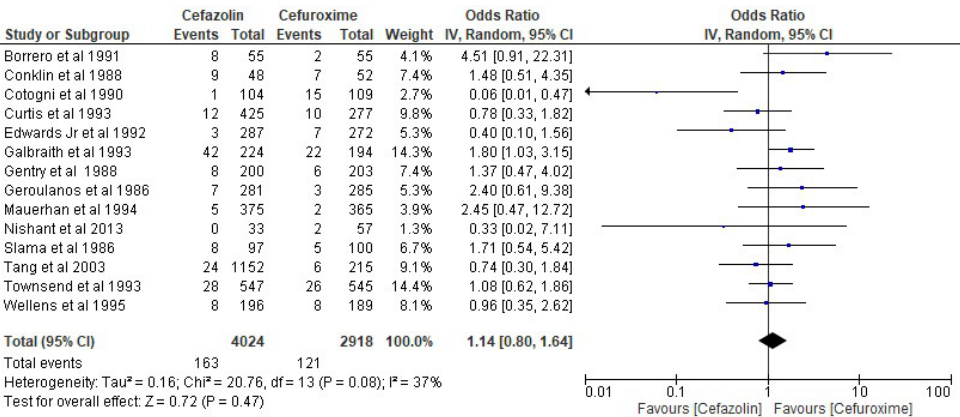
Figure 3. The rate of SSIs in the cefazolin group vs. cefuroxime group. The included studies were